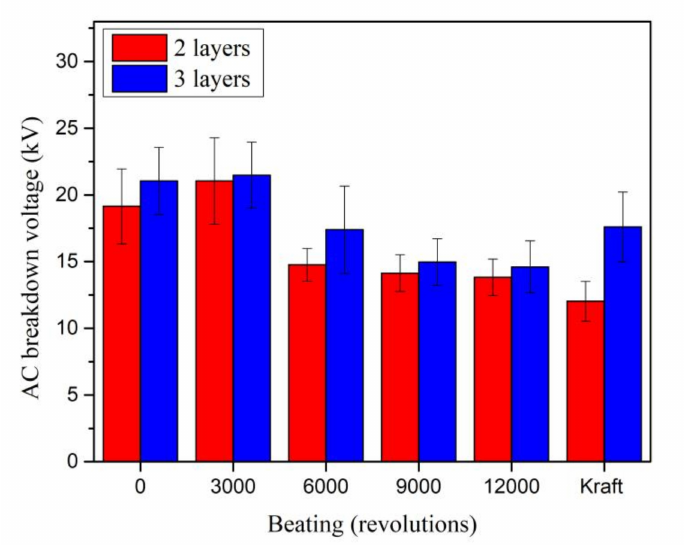
Figure 21. AC breakdown voltage of Kenaf and Kraft papers at di ff erent layers and beating